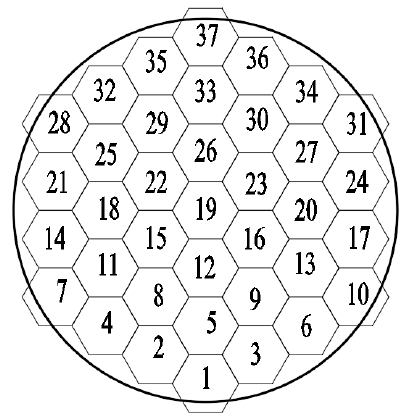
Figure 1. Cross-section of datum cable.